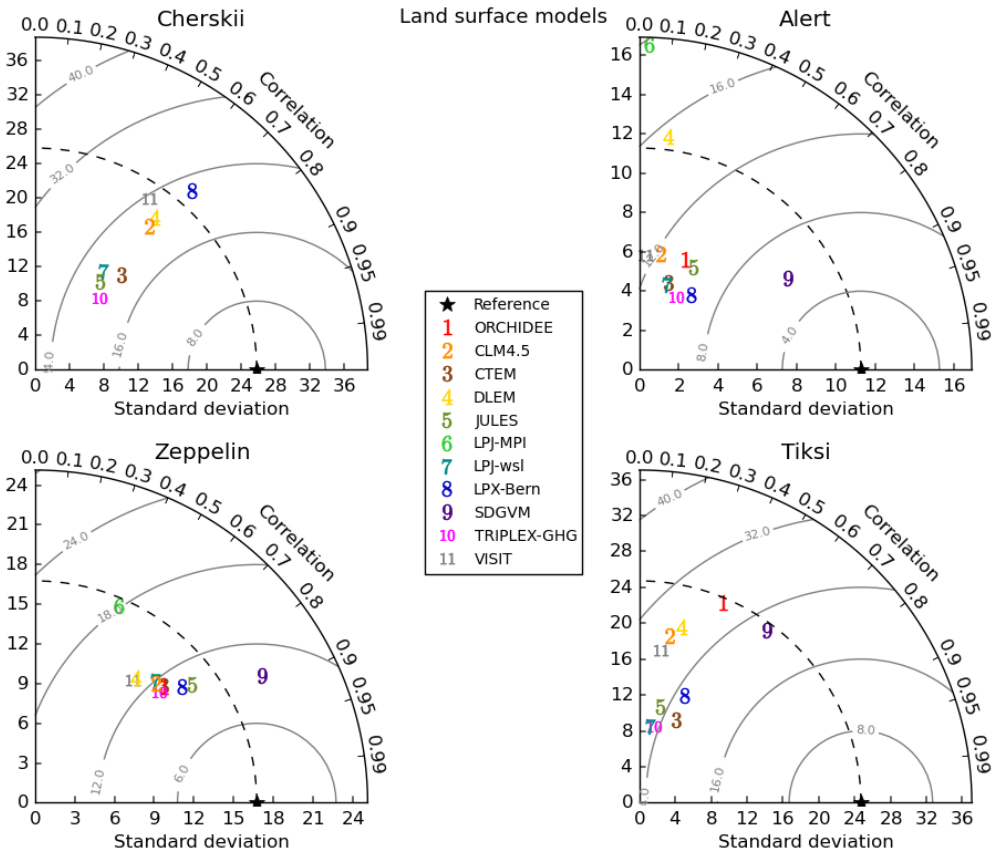
Figure 8. Taylor diagram representations of the comparison between observations (star marker) and CH 4 simulations using the outputs of 11 land-surface models, at four measurement sites (Cherskii, Alert, Zeppelin, and Tiksi). If we consider model 6 in Zeppelin, its correlation with observations is related to the azimuthal angle ( R = 0.4); the centred root mean square (rms) difference between simulated and observed CH 4 is proportional to the distance from the star marker on the x axis, indicated by the grey contours (rms = 18ppb); the standard deviation of simulated CH 4 is proportional to the radial distance from the origin (SD = 16ppb). ORCHIDEE, LPJ-MPI, and SDGVM do not appear in the Cherskii plot; LPJ-MPI does not appear in the Tiksi plot. This is because of higher standard deviations found with these